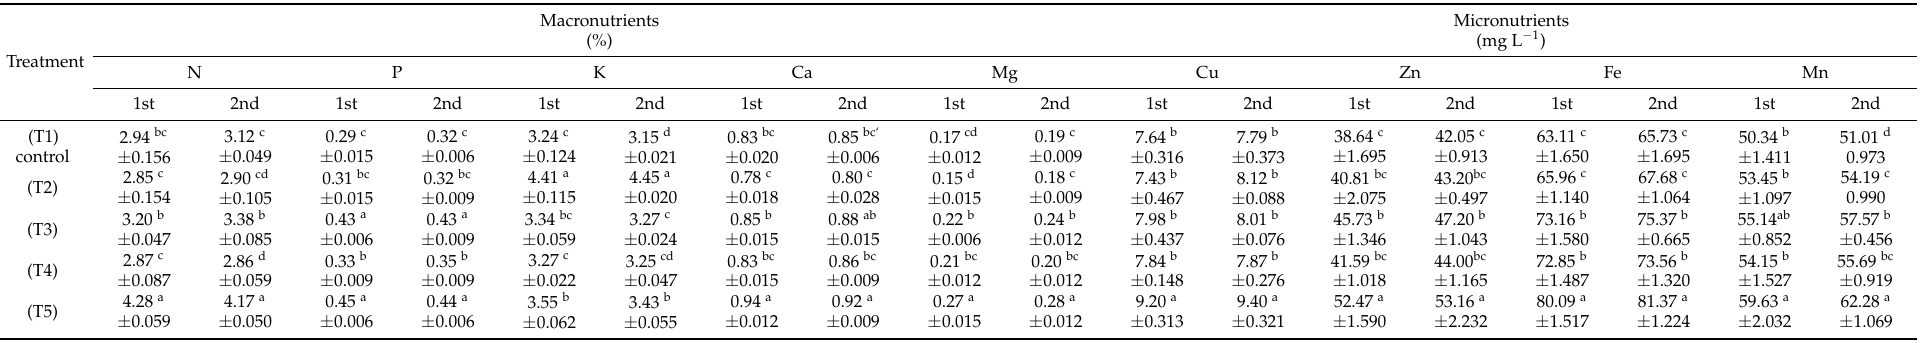
Table 5. Leaf endogenous nutrient contents under drought conditions and different nanoparticle applications on Solidago canadensis plants during the 2020 and 2021 growing